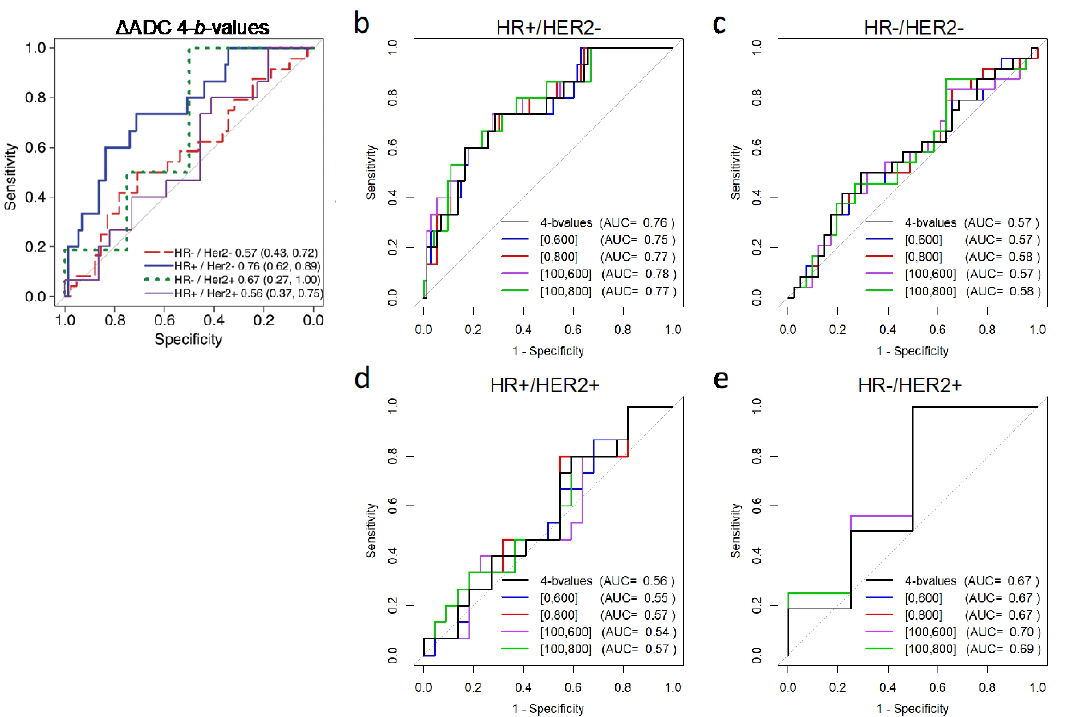
Figure 7. Subtype-based ROC analysis for prediction of pCR based on mid-treatment change in ADC. Shown are ( a ) ROC curves for percent change in tumor ADC calculated using all four b -values (0/100/600/800 s/mm 2 ) stratified by cancer subtype. Additionally shown are ROC curves for two versus four b -value ADC calculations separately for participants with cancer subtypes of ( b ) HR+/HER2 − (N = 88), ( c ) HR − /HER − (triple-negative; n = 65), ( d ) HR+/HER2+ (n = 37), and ( e ) HR − /HER2+ (N = 20). In panels ( b – e ), the ROC curve for the reference four- b -value ADC is shown in black. Abbreviations: AUC, area under the ROC curve; HR, hormone receptor; HER2, human epidermal growth factor receptor 2. Figure 7a reprinted from Partridge et al. Radiology 2018; 289 (3):